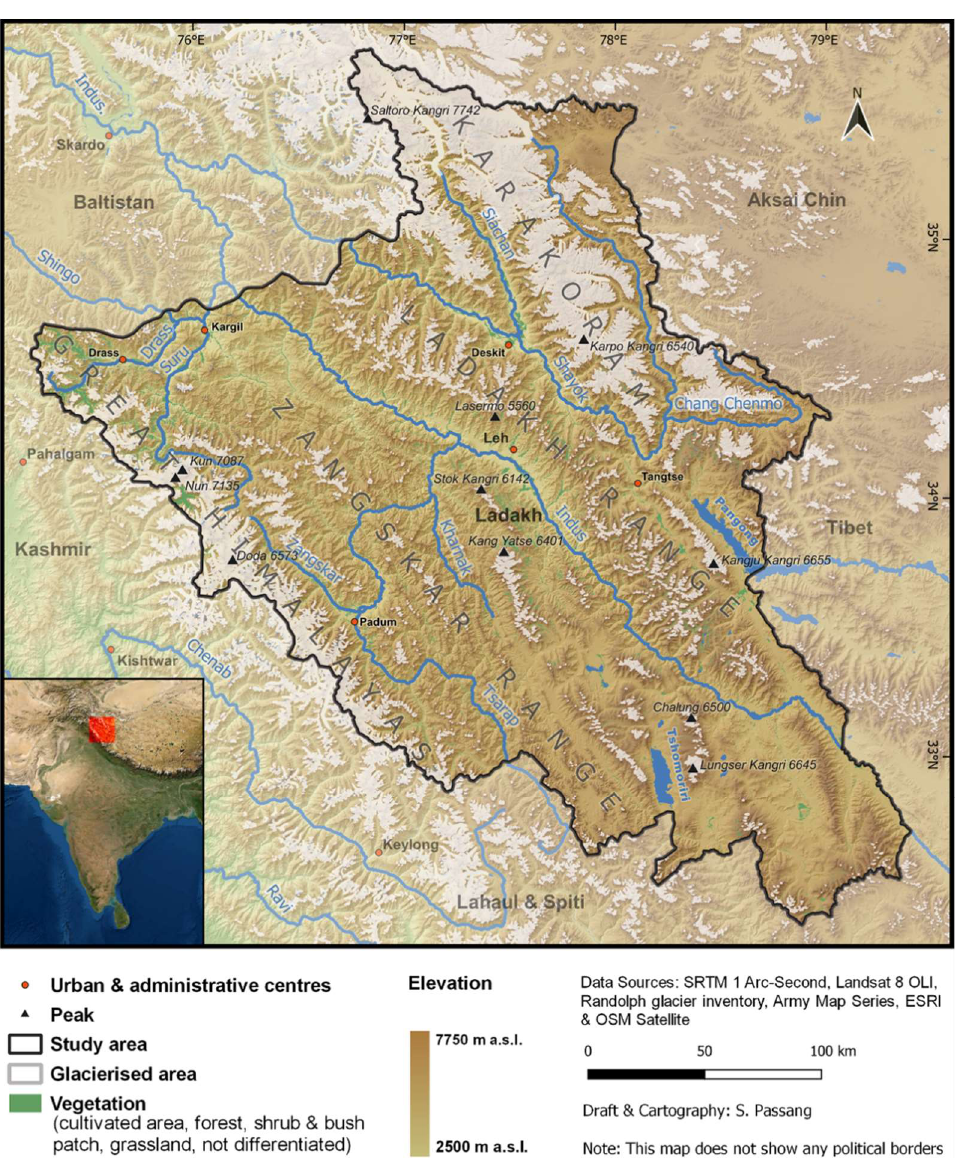
Figure 1. The Trans-Himalayan region of Ladakh, sandwiched between the Greater Himalayas, the Karakoram, and the Tibetan plateau. Place names follow the spelling in Ladakhi language [26], e.g., Zangskar (Zanskar), Tshomoriri (Tso Moriri), and Siachan (Siachen).